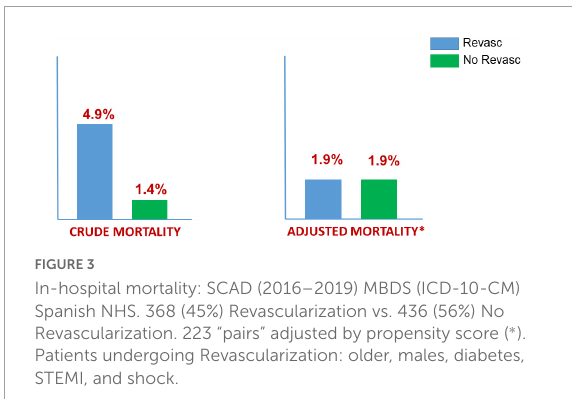
FIGURE3 In-hospital mortality: SCAD (2016–2019) MBDS (ICD-10-CM) Spanish NHS. 368 (45%) Revascularization vs. 436 (56%) No Revascularization. 223 “pairs” adjusted by propensity score ( ∗ ). Patients undergoing Revascularization: older, males, diabetes, STEMI, and shock.